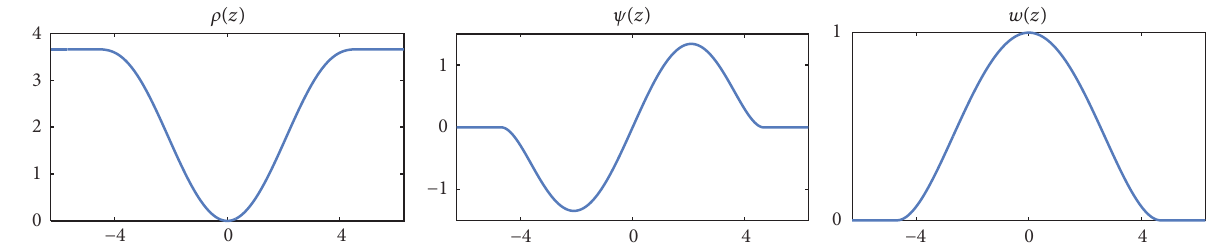
Figure 1: Tukey’s biweight estimator objective, 𝜓 , and weight functions for 𝑐 = 4.685 .